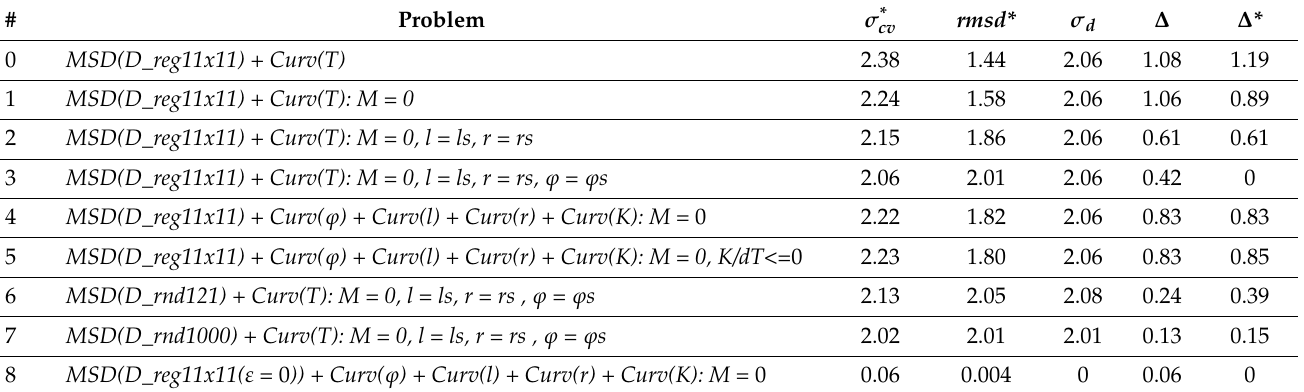
Table 1. Errors: σ ∗ cv –error of cross-validation, the main indicator of the “quality” of the constructed model; rmsd * is the standard deviation of the SvF solution from observations, σ d is the data error, ∆ is Table 1. Errors: the standard deviation of the SvF solution from the exact solution, ∆ * is the estimate of ∆ determined by Formula